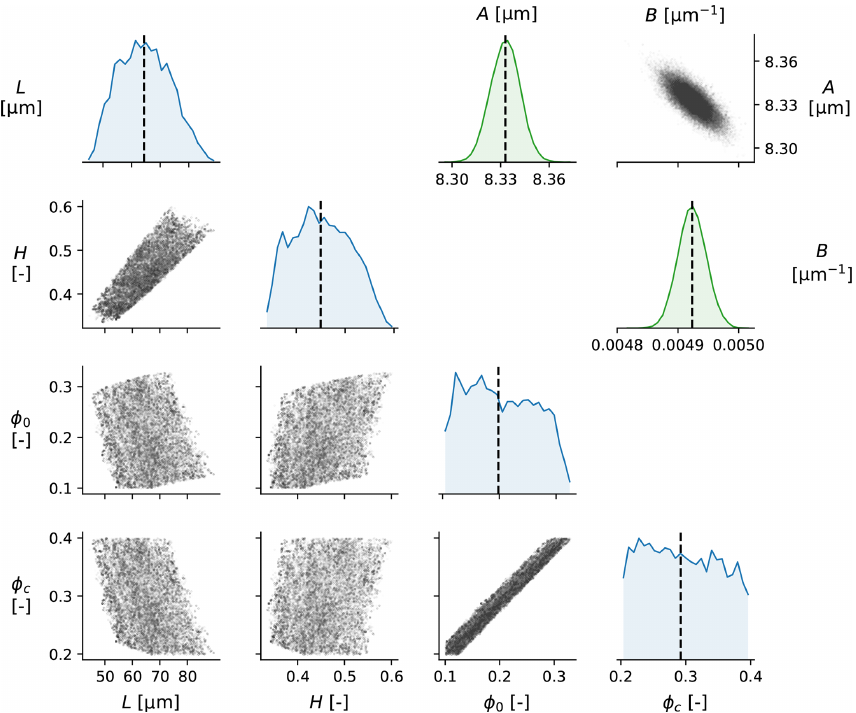
Figure 2. Lower triangle (blue graphs and those below them): corner plot of the posterior distributions of the inverted parameters L , H , φ 0 , and φ c (marginalised over the nuisance parameter ν 2 ) for the laboratory injection experiment. The main diagonal panels show the posterior probability density distribution of each parameter, whereas the off-diagonal panels show the co-variance of posterior samples. The black dashed lines in the distribution plots (main diagonal) indicate the median value. Upper triangle (green graphs and the one above them): corner plot of the posterior distributions of A and B (see main